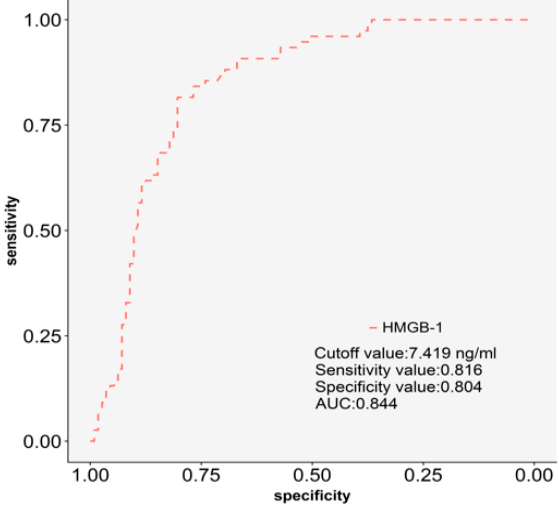
Figure 3. Receiver operating characteristic (ROC) curve analysis for the discriminatory power of plasma HMGB-1 for silicosis.